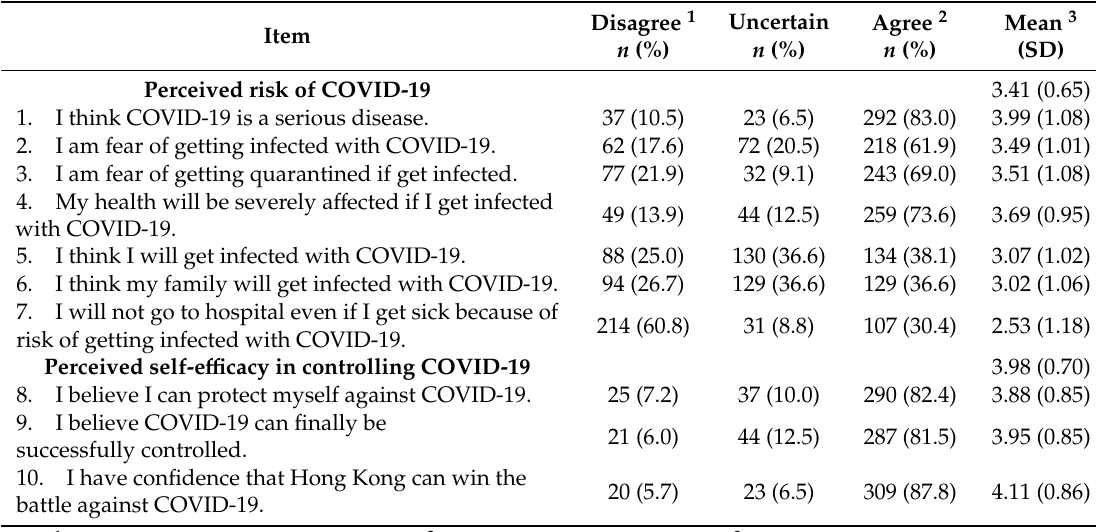
Table 3. Responses of attitude